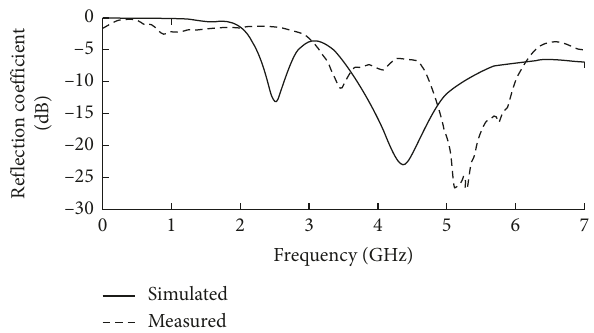
Figure 7: Measured reflection coefficient in free-space of the cavity-backed antenna